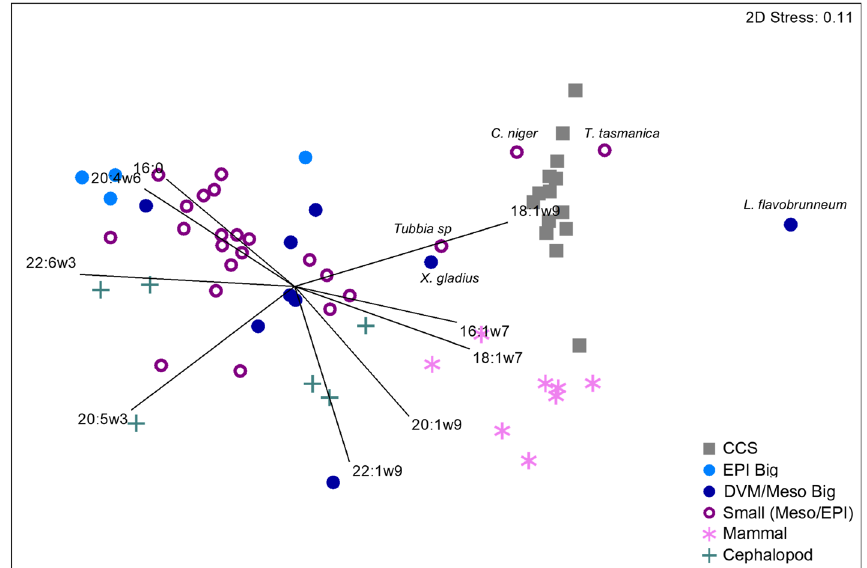
Figure 5. Non-metric MDS of Cookiecutter shark muscle and liver (grouped, CCS) and potential prey item FA profiles (% contribution). Vector overlays show FAs with PCO correlation values > 0.8.